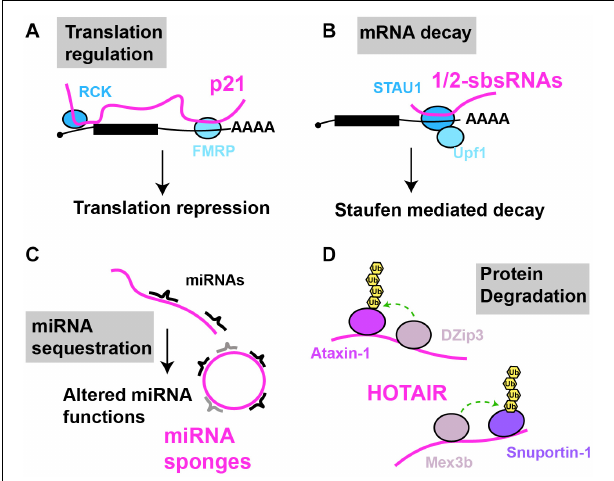
FIGURE 3 | Examples of cytoplasmic RNA scaffolds and decoys. Scaffold and decoy RNAs are depicted in pink (A) mRNA translation: lncRNA-p21 partially base pairs with target mRNAs leading to the recruitment of translation repression factors like RCK and FMRP, thus inhibiting mRNA translation. (B) mRNA decay: 1/2sbsRNAs base pair with target mRNAs; the resulting dsRNA recruits Staufen, leading to staufen-mediated mRNA decay. (C) miRNA sequestration: various lncRNAs (linear and circular) in multiple species, regulated in a tissue, developmental or environmentally sensitive manner, can base-pair with and sequester miRNAs, preventing their regulation of mRNA translation or decay. (D) Protein degradation: HOTAIR lncRNA binds to two ubiquitin ligases and their substrates causing their ubiquitination and